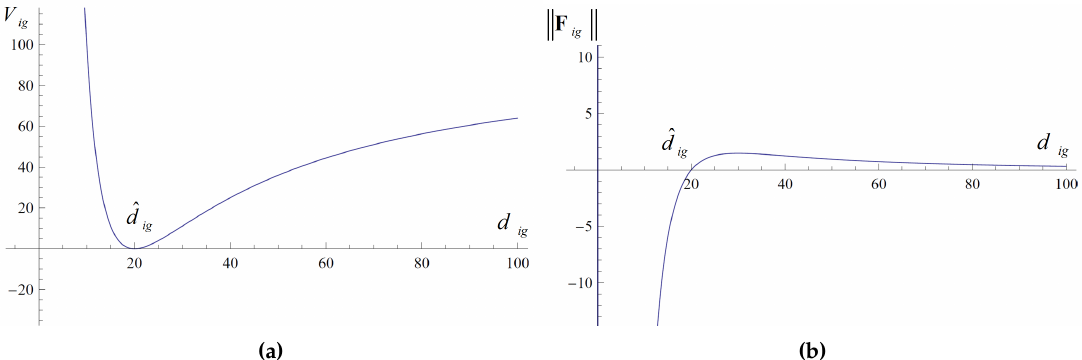
Figure 3. ( a ) The artificial potential function V ig between the sensor D i and its target point g i ; ( b ) the gradient of V ig ( ˆ d ig = 20, (cid:101) ig =